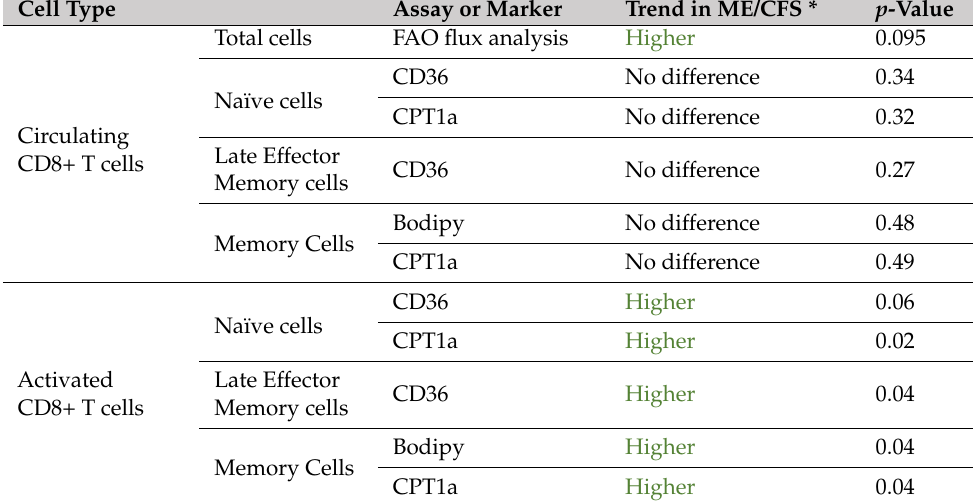
Table 4. Summary of results concerning FAO in ME/CFS vs. control CD8+ T